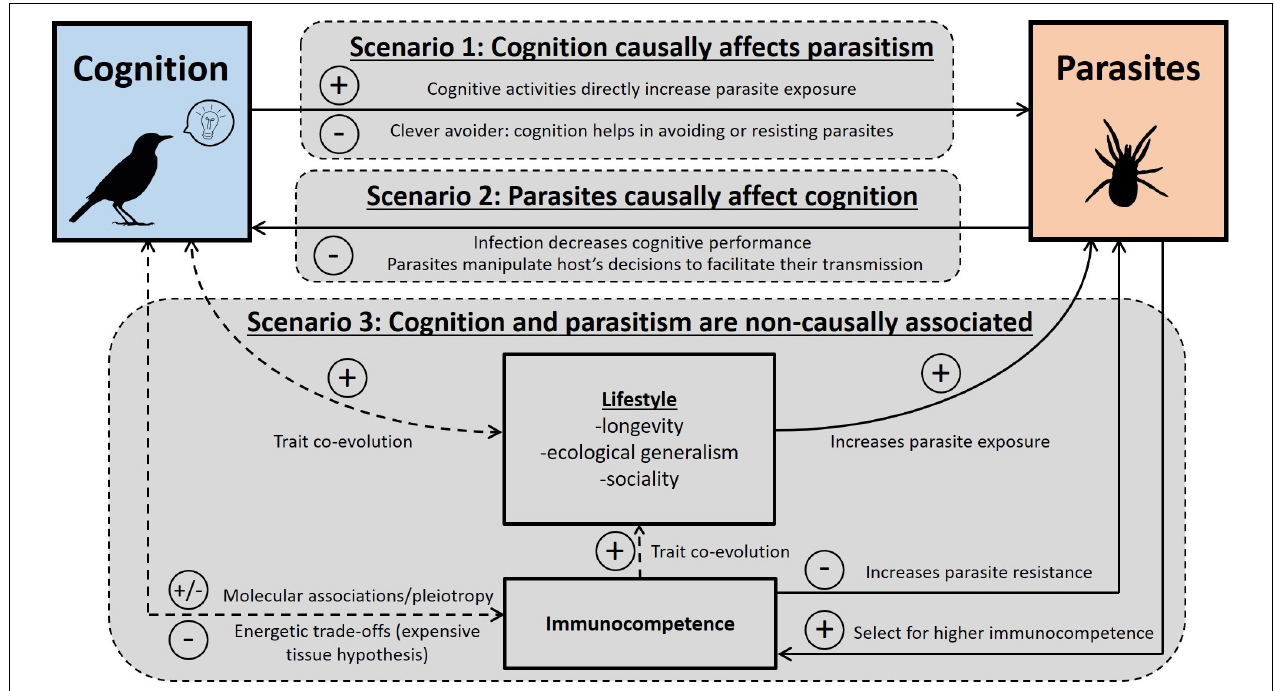
FIGURE 1 | Diagram presenting the different scenarios predicting associations between host cognitive traits and parasitism. Each of the three scenarios involves one or more different mechanisms. Solid arrow: causal association. Dashed arrow: non-causal association resulting from constraints or trait co-evolution. + : positive associations expected; – : negative associations expected; ± : both positive and negative associations